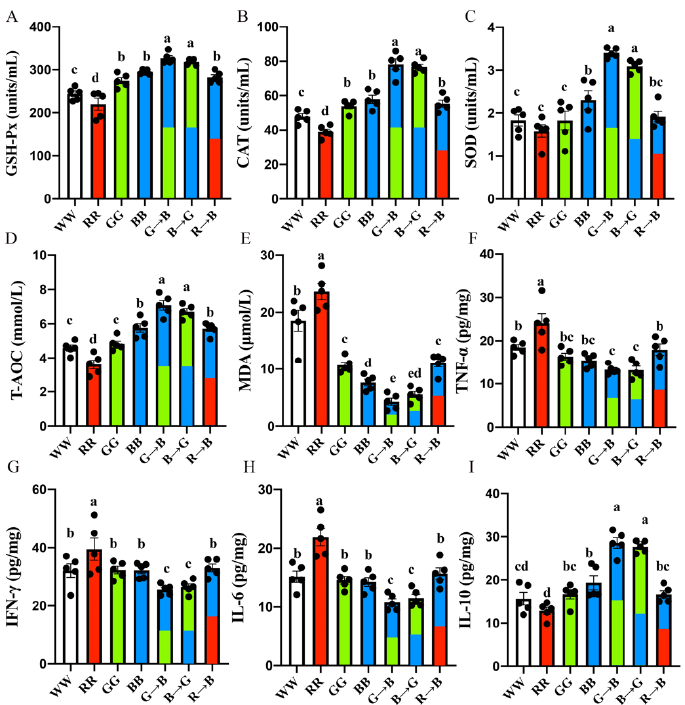
Figure 2. Plasma GSH-Px ( A ), CAT ( B ), SOD ( C ), T-AOC ( D ), MDA level ( E ), bursal TNF- α ( F ), IFN- γ ( G ), IL-6 ( H ), IL-10 ( I ) level in the chick at P42. The results of each group were expressed as the mean ± standard error. Differences between seven light treatment groups were evaluated by one-way ANOVA, and values with no common letters differ significantly ( p < 0.05).